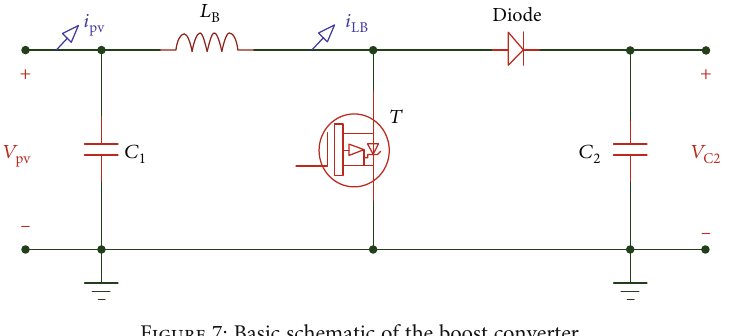
Figure 7: Basic schematic of the boost